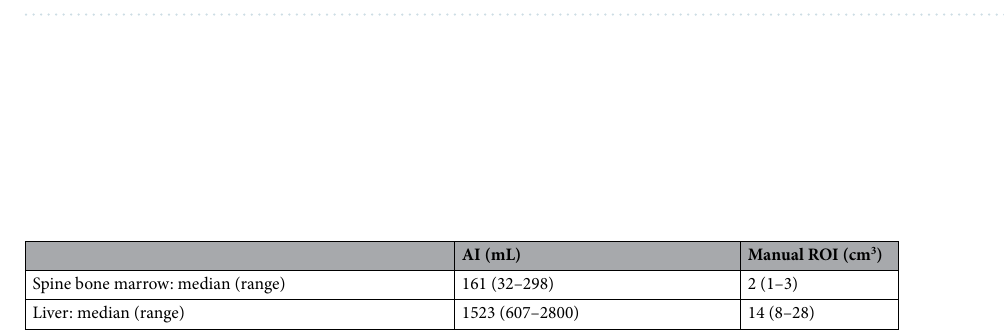
Figure 4. Bland–Altman plot: comparison between the SUV index calculated by the artificial intelligence (AI)- based method versus the manual method.